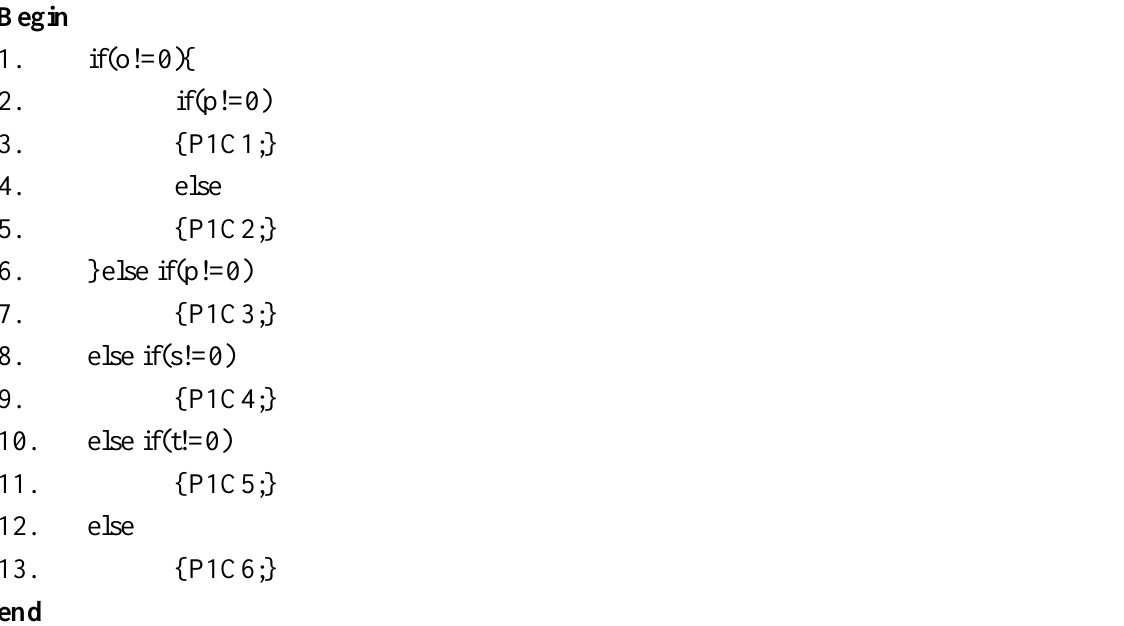
Algorithm 1 Procedure 1 of the First-Scan Method in the Proposed Algorithm